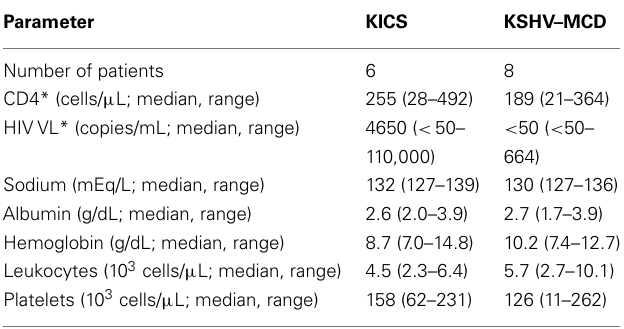
Table 1 | Key clinical and laboratory findings in patients with KICS and